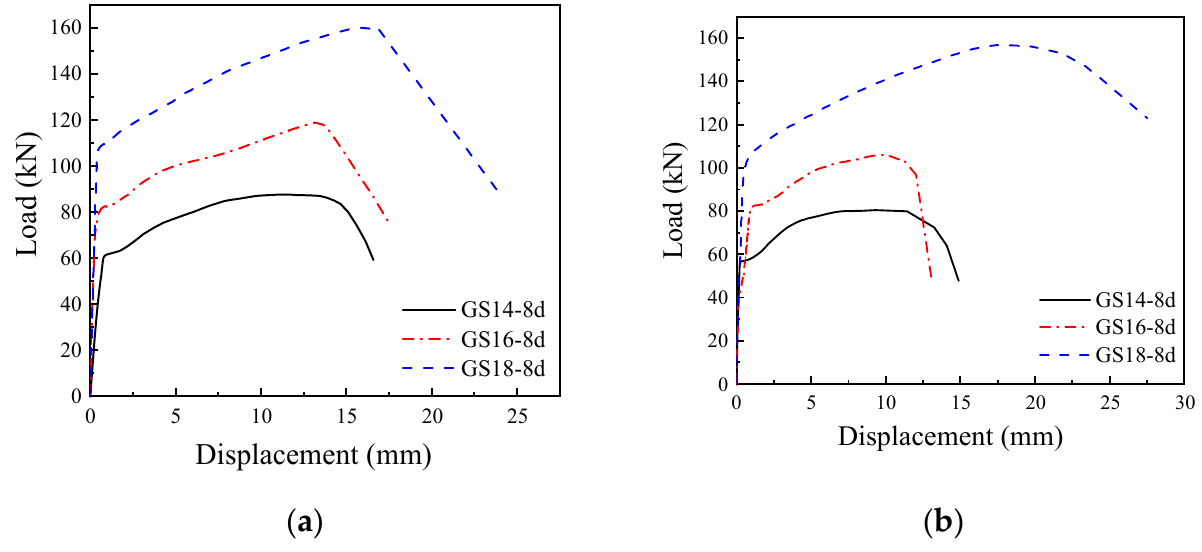
Figure 14. Load–displacement curves of the specimens with different reinforcement diameters. ( a ) Without random defects. ( b ) With 10% random